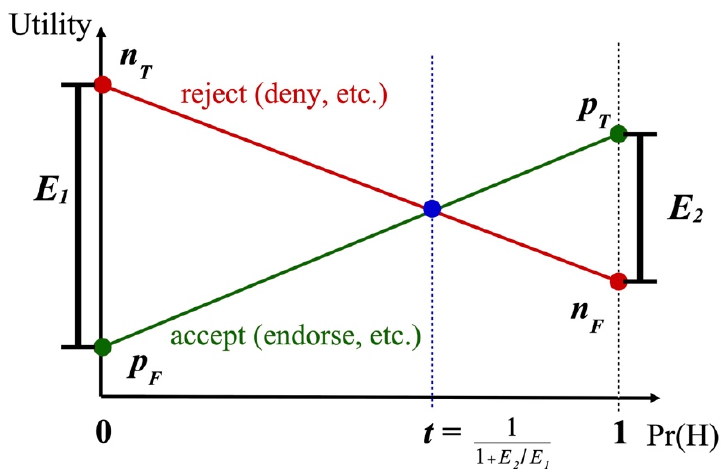
Figure 1. A model of how utilities affect inquiry in the simplified case of two options: “accept” or “reject” the given hypothesis, H. Pr(H) is the subjective probability assigned to H by a given expert or group of experts in light of available evidence. As indicated in parentheses, similar models may be framed in terms of alternative pairs of attitudes or actions, such as publicly “endorse” vs. “deny” (note that the utility of acceptance may differ from that of endorsement or assertion—see sections 3 and 8). Adding additional options like “no result” yields additional confidence thresholds between rational changes in attitude or behavior. The cost of a false positive ( E 1 ) is the difference in utility between a true negative ( n T ) and false positive ( p F ). The cost of a false negative ( E 2 ) is the difference in utility between a true positive ( p T ) and false negative ( n F ). When Pr(H) < t = 1/(1+ E 2 /E 1 ), rejecting H maximizes expected utility. When Pr(H) > t , accepting H maximizes expected utility.